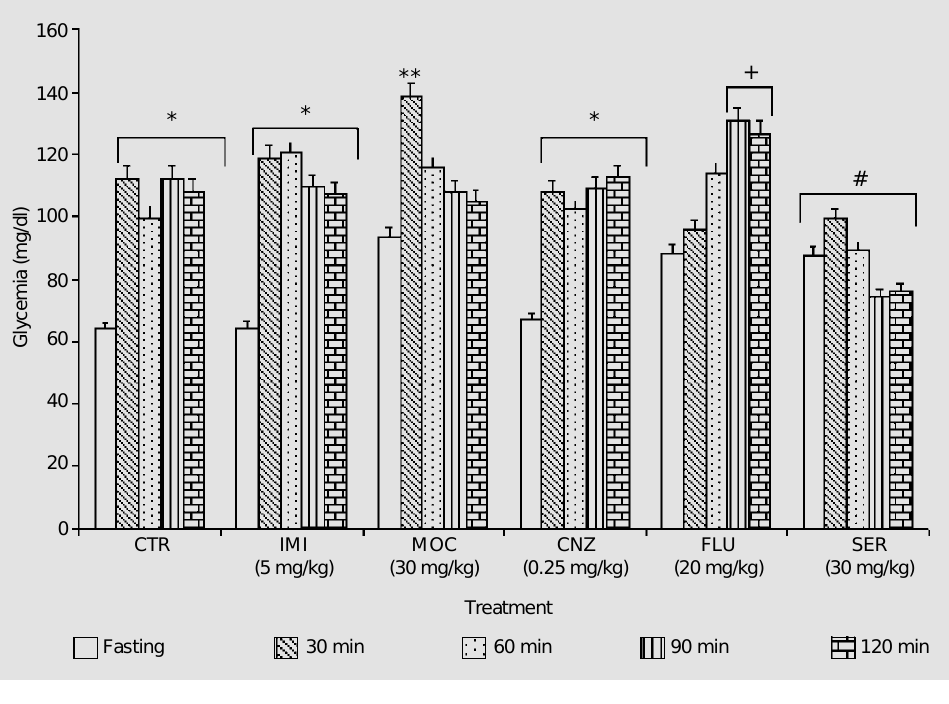
Figure 1 - Oral glucose tolerance test of non-diabetic rats treated with antidepressant agents.